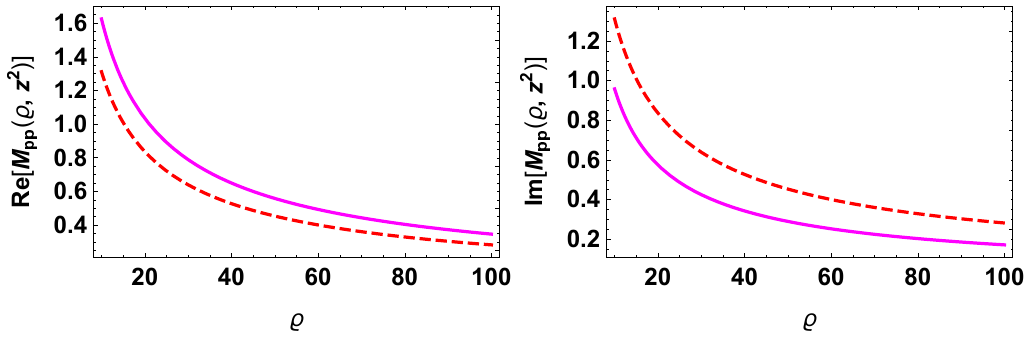
Figure 5 . In the left panel, the orange curve is the numerical evaluation of real part of eq. (5.11) (all twist resummed by BFKL), the green dashed curve is the real part of the LT term in (6.12) only, while the red dashed one is the real part of LT+NLT result, eq. (6.12). In the left panel we plot the imaginary parts. The range of % is from 10 to 100 .